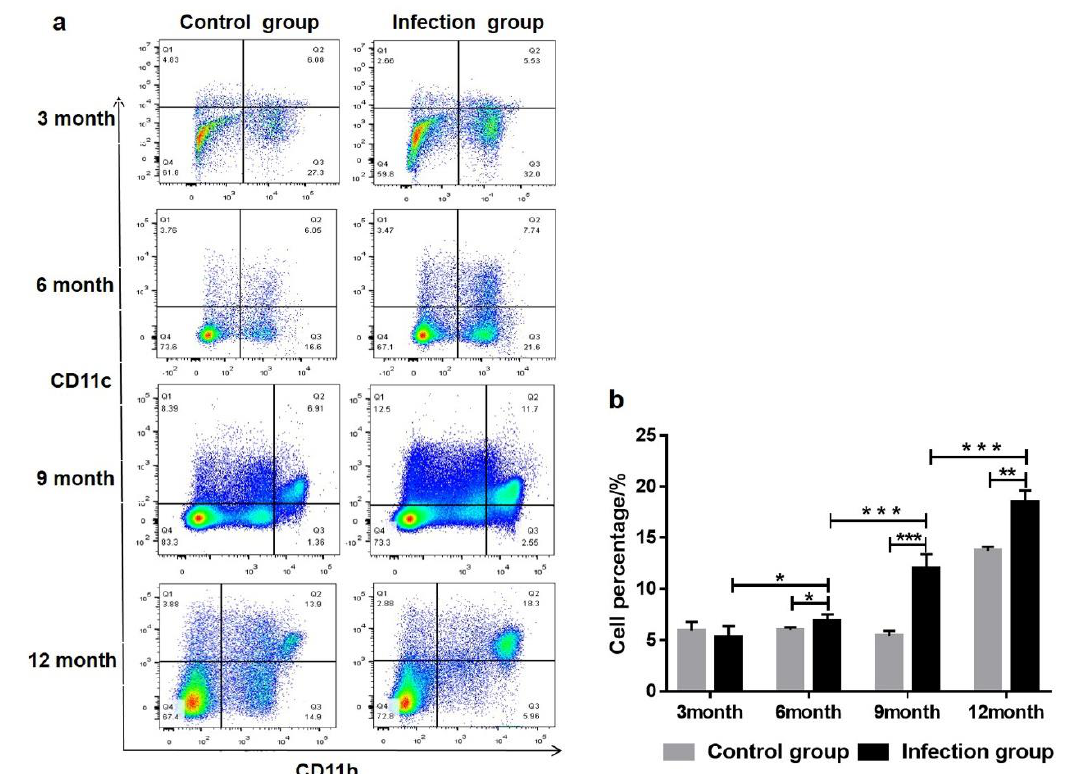
Figure 3. The percentage of dendritic cells (DCs) in the liver leukocytes of mice at each stage post- E. granulosus infection. ( a ) Flow cytometry detection of the percentage of DCs in the liver leukocytes of mice at 3, 6, 9, and 12 months post-infection; ( b ) Statistical analysis of the percentage of DCs. * p < 0.05, ** p < 0.01, *** p < 0.001.